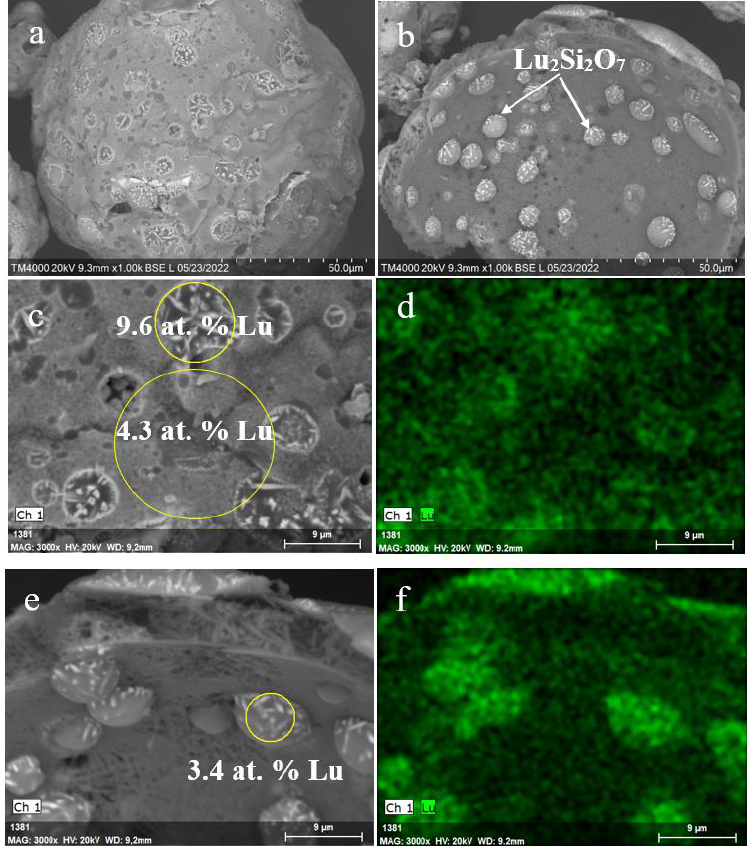
Figure 7. SEM images of the Lu 3+ loaded NaX microspheres ( a ), internal surface of the microsphere globule ( b ), and local parts of the microsphere external ( c ) and internal surface ( e ) after thermal treatment at 1273 K; Lu distribution maps ( d , f ) for the local parts ( c , e ) of the microspheres. As for the Lu 3+ containing NaP1 microspheres, there are no pronounced local inho- mogeneities of lutetium concentration over the zeolite-derived surface layer after calcina- tion at 1273 K (Figure 8). The almost smooth surface without growths and cavities, uni- form Lu distribution, and Lu content of up to 16 at. % are distinctive features of the Lu encapsulated microspheres based on the NaP1 precursor.